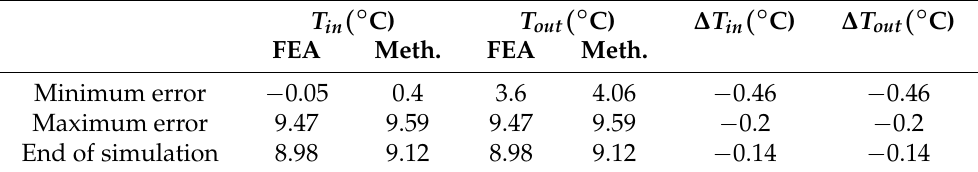
Table 5. Errors of fluid temperatures during the 7-day period.